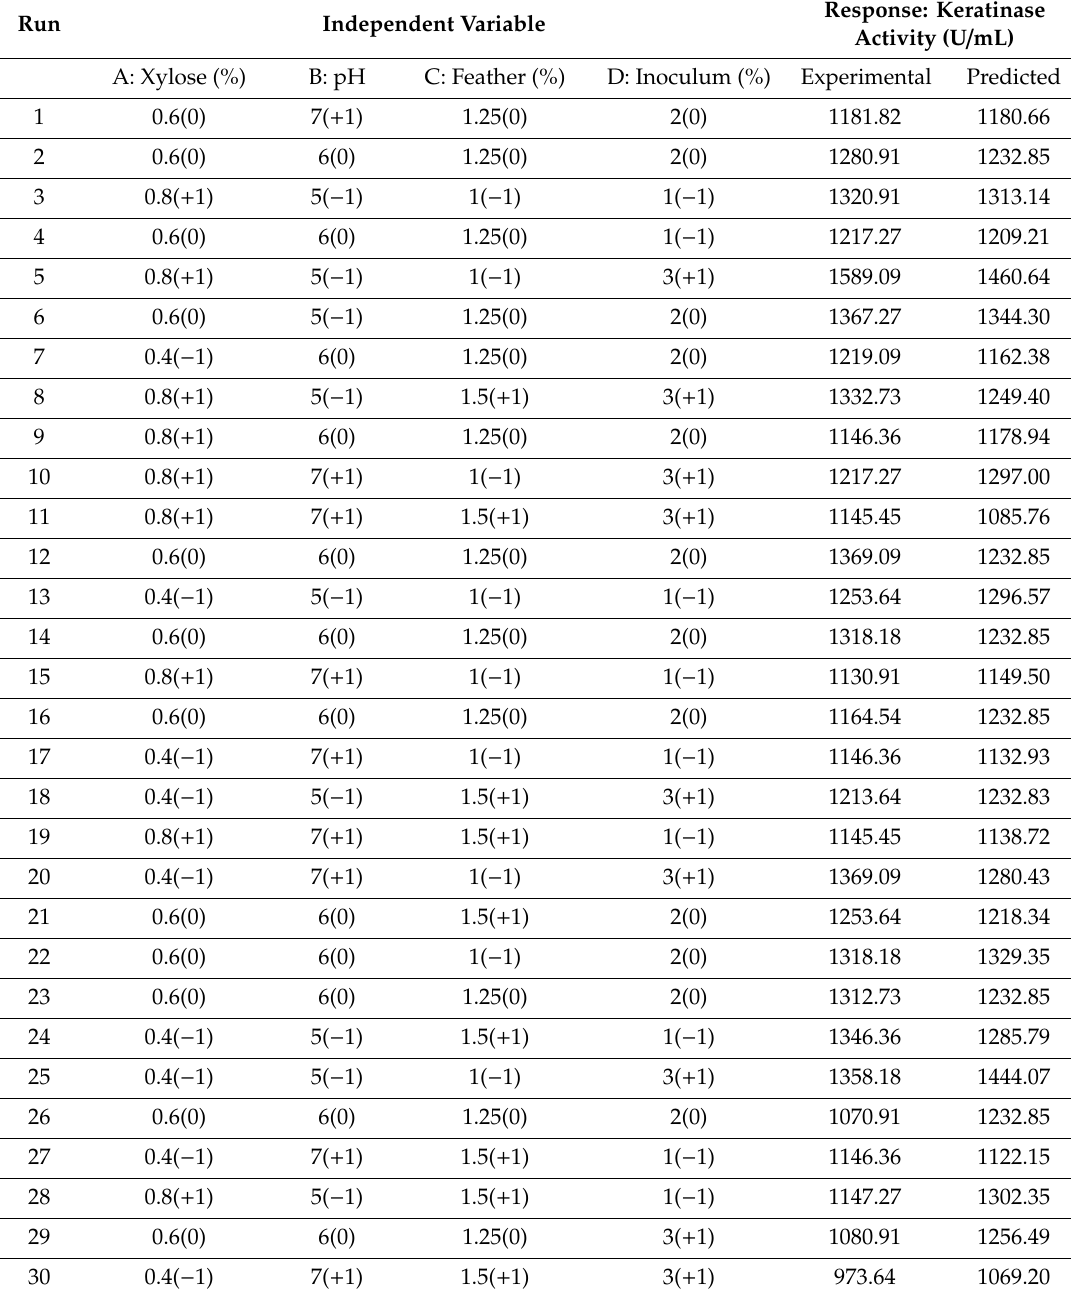
Table 2. Central composite design (CCD) design of RSM using four independent variables showing actual and predicted values of keratinase activity by Bacillus sp.